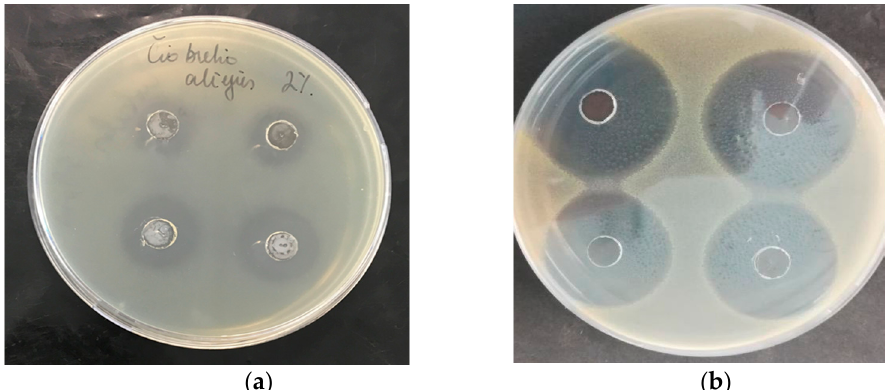
Figure 3. Antibacterial activity of thyme ( Thymus vulgaris ) essential oils concentration 1% ( a ) and 2% ( b ) against X. arboricola NRCIB X7. Table 4. Antibacterial activity of blueberry and cranberry aqueous extracts against Xanthomonas spp.